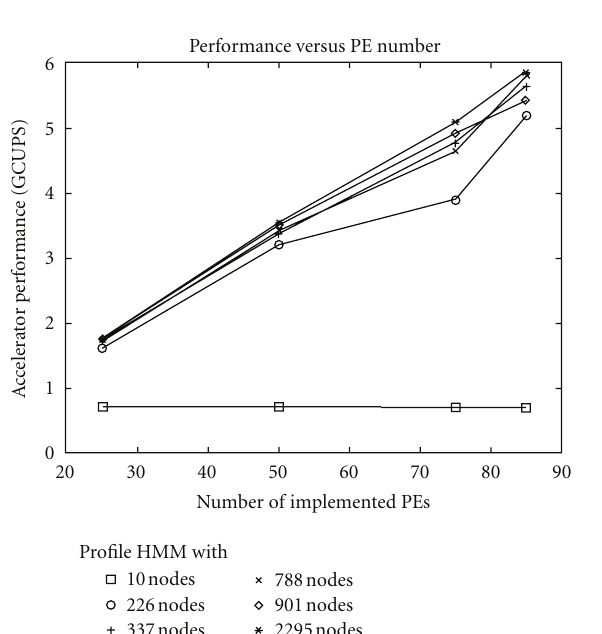
Figure 16: Performance versus number of HMM nodes envelope